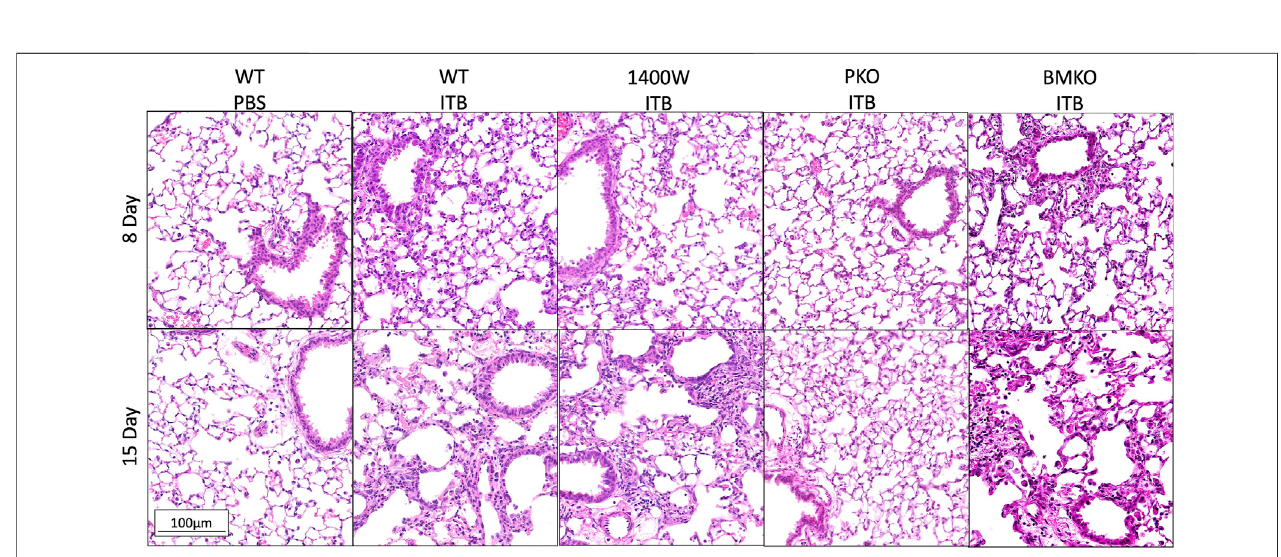
FIGURE 7 | Lungs collected post lavage were stained by H&E and morphology assessed. Representative images are shown for each group. Representative pictures are at 200x. ( n = 3 – 7)